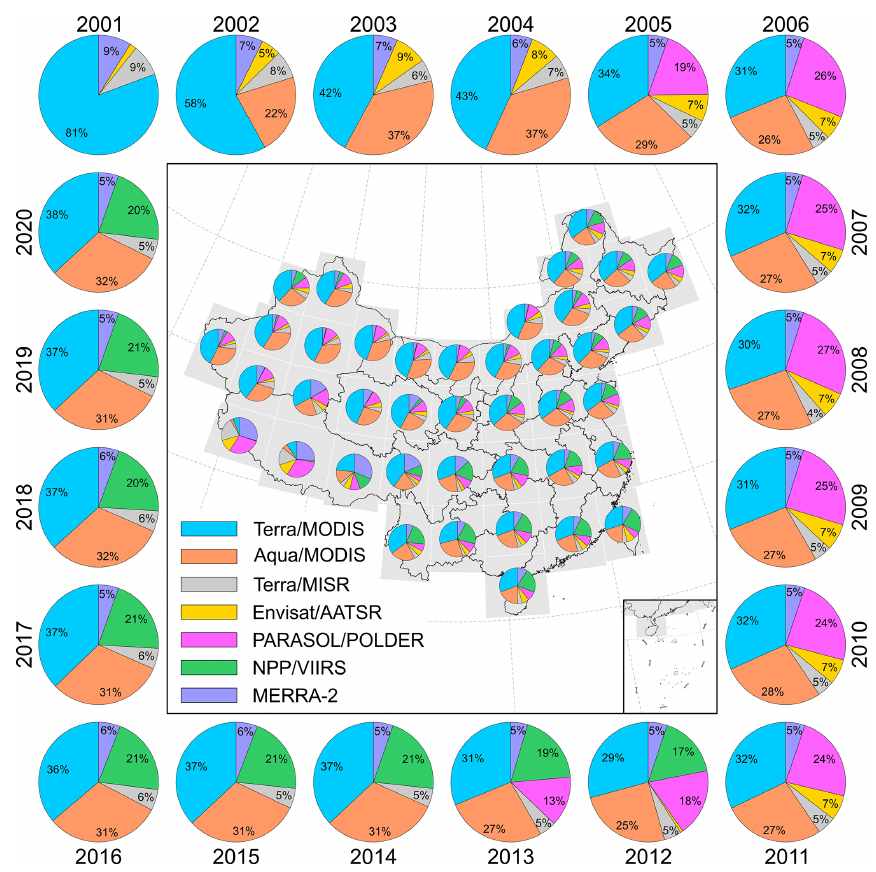
Figure 5. Spatiotemporal variations in the relative contribution of each gridded AOD product to the generation of the LGHAP AOD dataset. The relative contribution was estimated as the data-coverage-ratio-weighted nonlinear correlation coefficient (please refer to Sect. S2 in the Supplement for the arithmetic theory to calculate this measure). The annual mean shown outside is the national averaged contribution in each individual year, while the regional mean shown on the map was averaged over the past 21 years in each